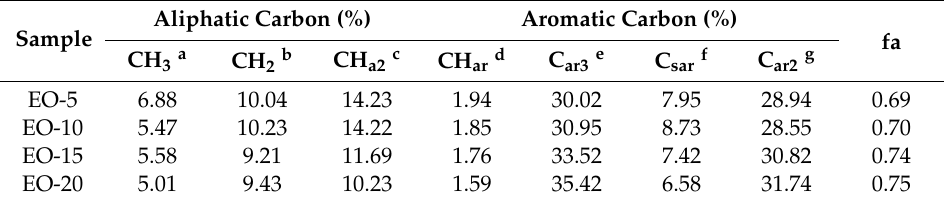
Table 3. Carbon atom determination of isotropic pitch precursors by 13 C NMR spectra.